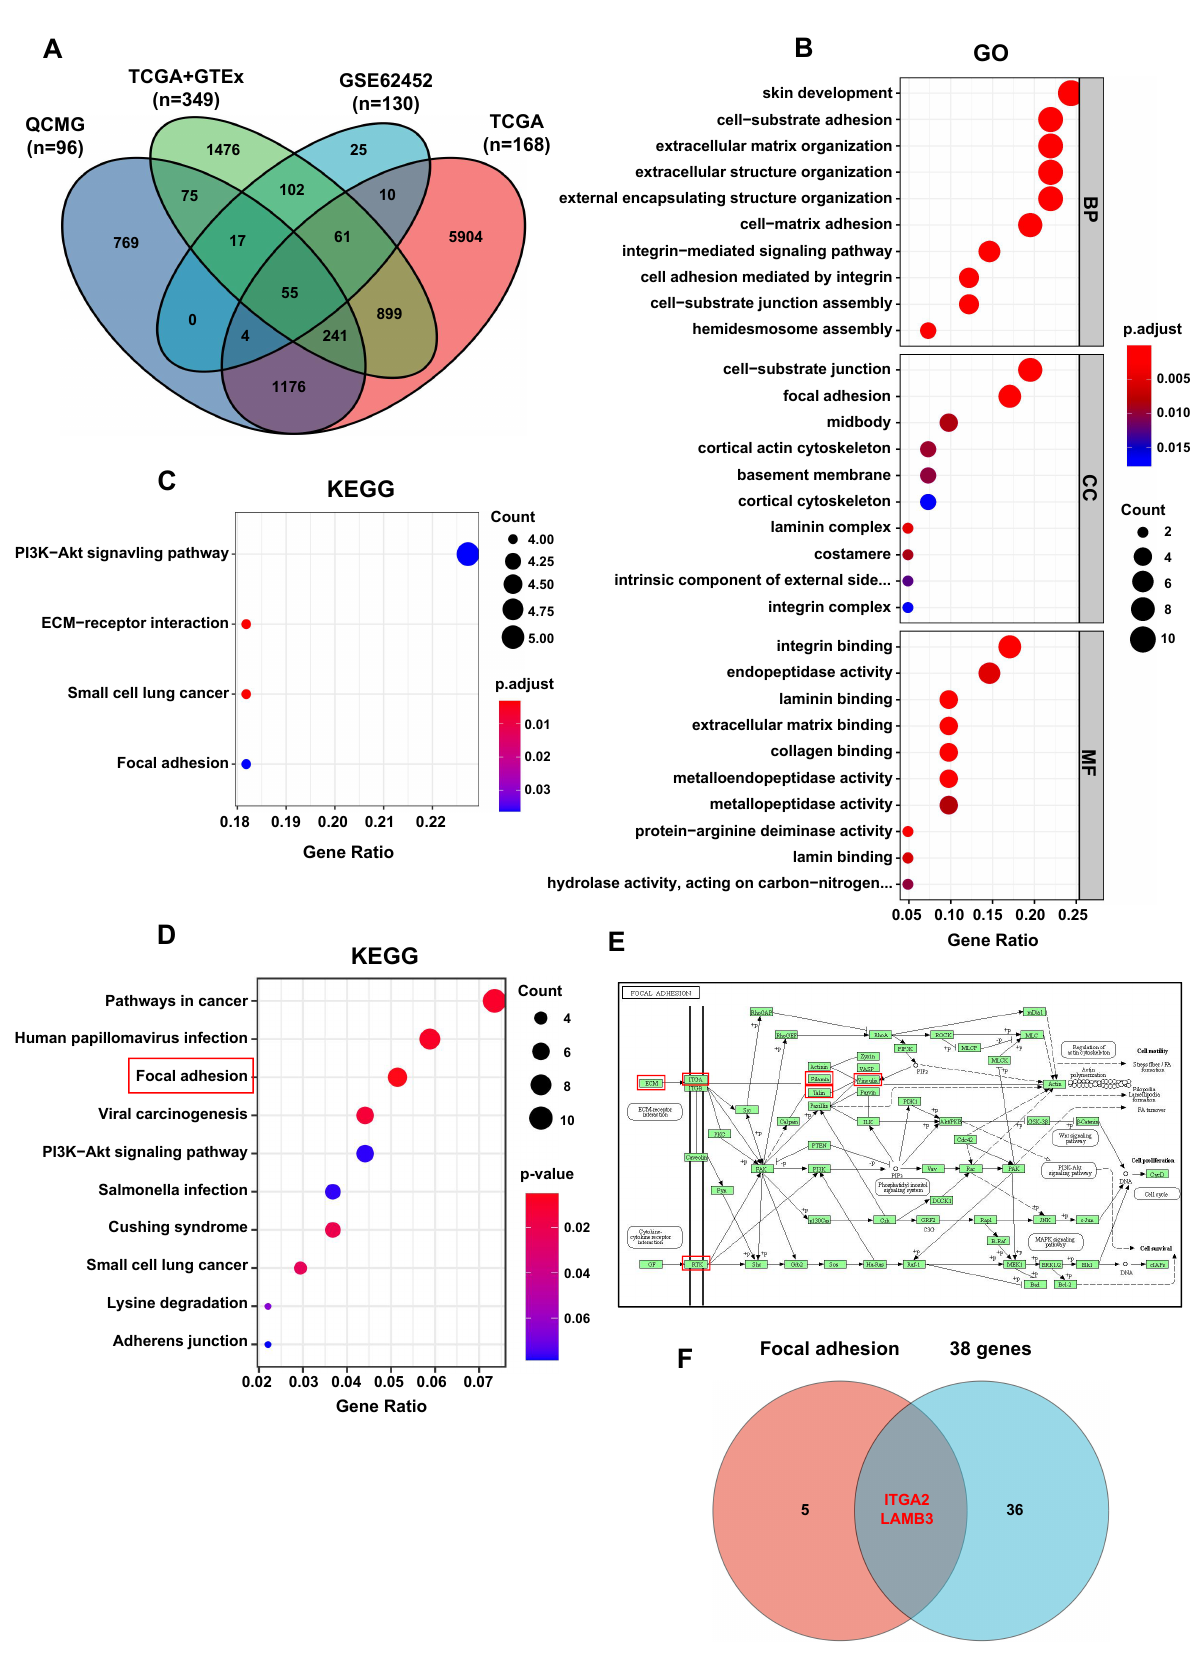
Figure 4. ITGA2 and LAMB3 are predicted to be activated by S100A10 in PDAC by integrated bioinformatic analyses. ( A )The intersection between the genes significantly associated with